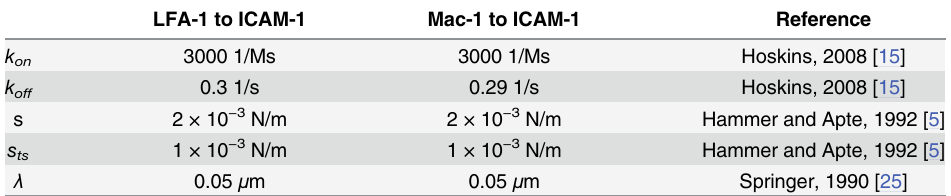
Table 4. Adhesion Parameters.